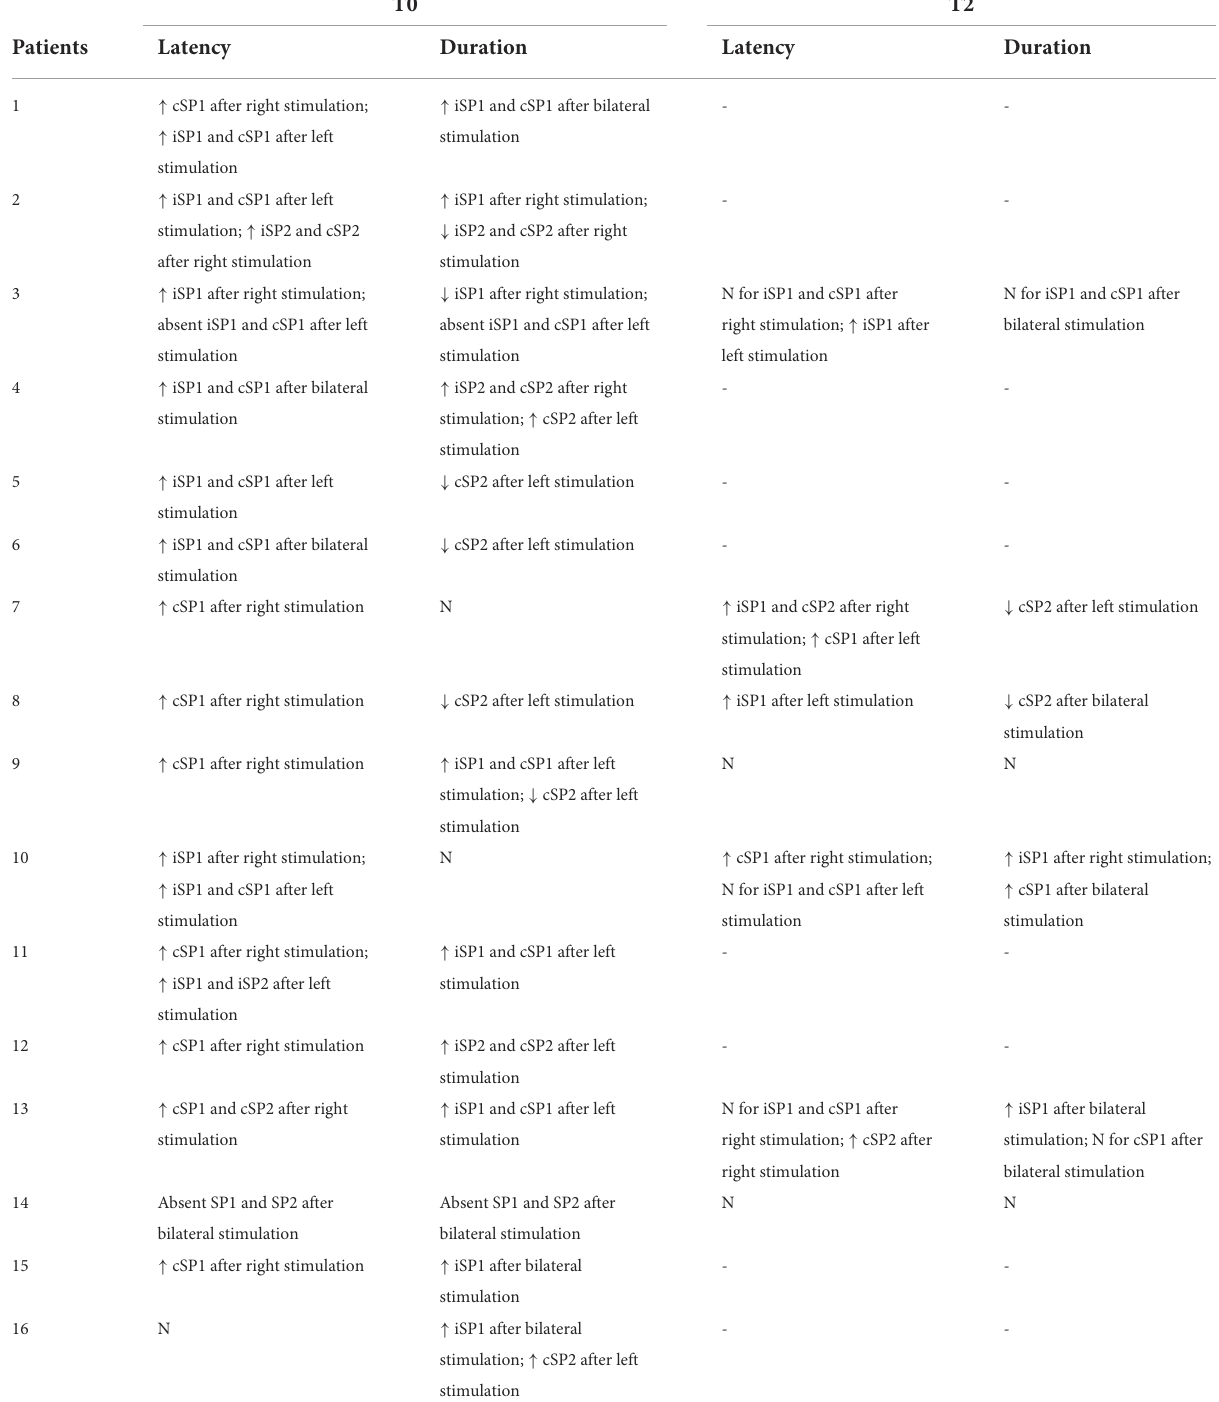
TABLE 4 Individual parameters of the masseter inhibitory reflex in COVID-19 patients as compared to healthy subjects at baseline and at 20-month follow-up. T0